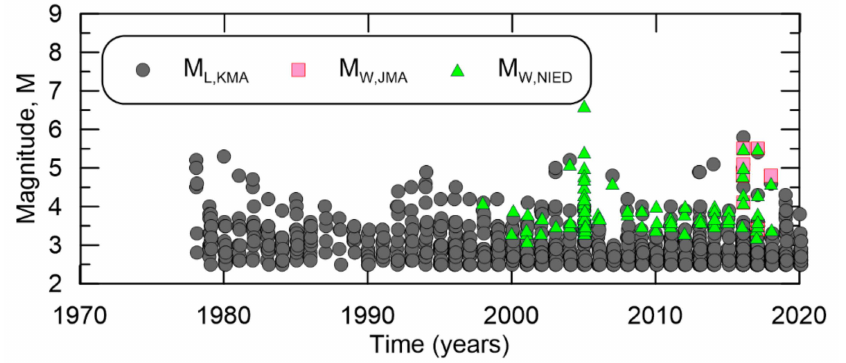
Figure 11. Local magnitude from KMA and moment magnitude types from Japanese sources, and timeframes when they are valid in the South Korean